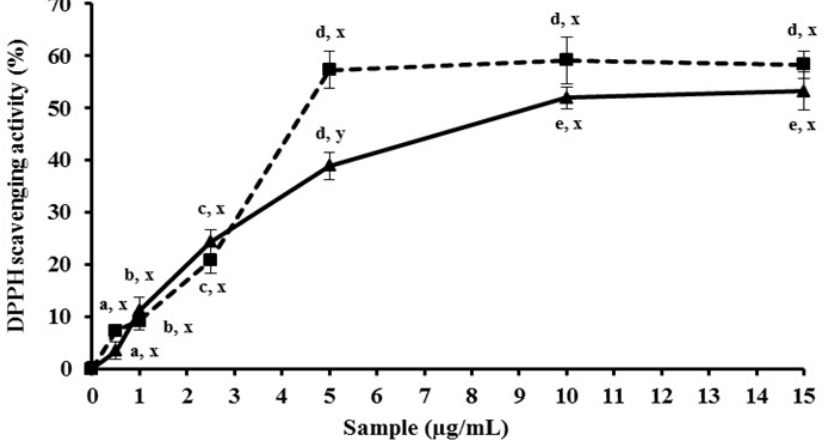
Figure 1. In vitro DPPH activity scavenging of MEC. The activity of Methanolic Extract is represented by the continuous line. The dashed line expresses activity of the known antioxidant α -tocopherol. MEC and positive control were used at the same concentrations (0; 0.5; 1.0; 2.5; 5.0; 10; 15 µg/mL). Letters a,b,c,d,e Indicate significantly differences between different concentrations of the same sample. x,y Represent significantly difference between different samples at similar concentrations. Student-Newman-Keuls test ( p <